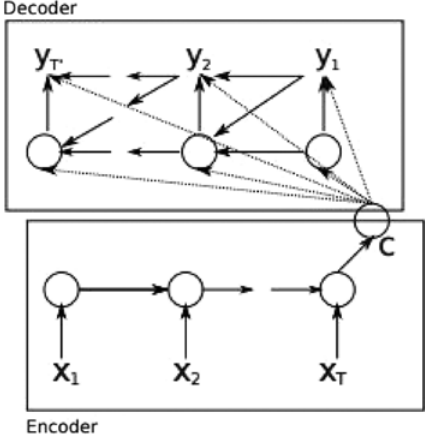
Figure 1: RNN Encoder-Decoder